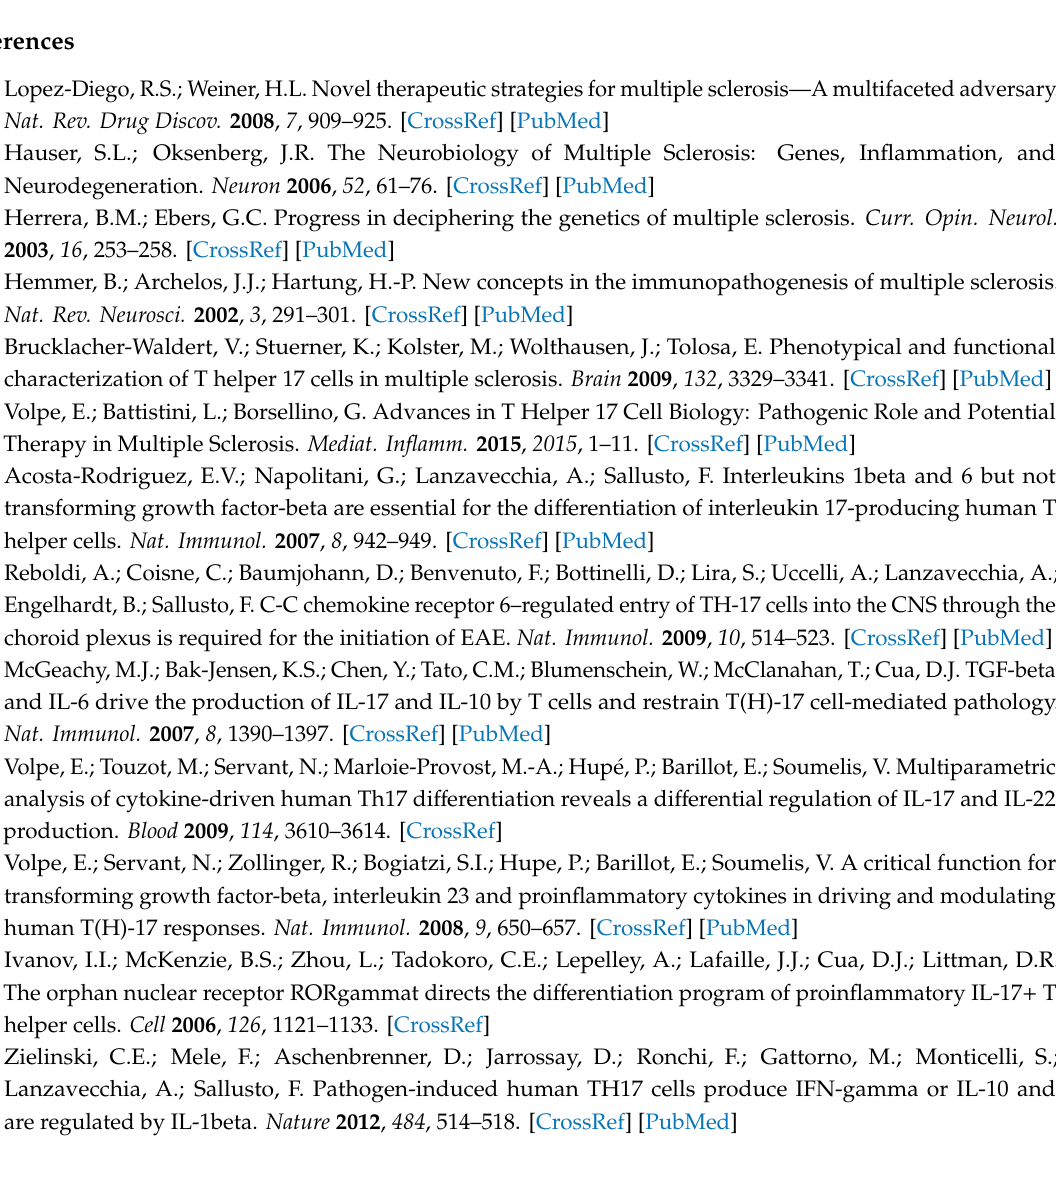
Figure S1: The ac4vity of MS disease does not modulate IL-1R1 expression on di ff eren4ated Th17 cells, Figure S2: The sinergy between Th17 polarizing cytokines contributes to IL-1R1 expression on Th17